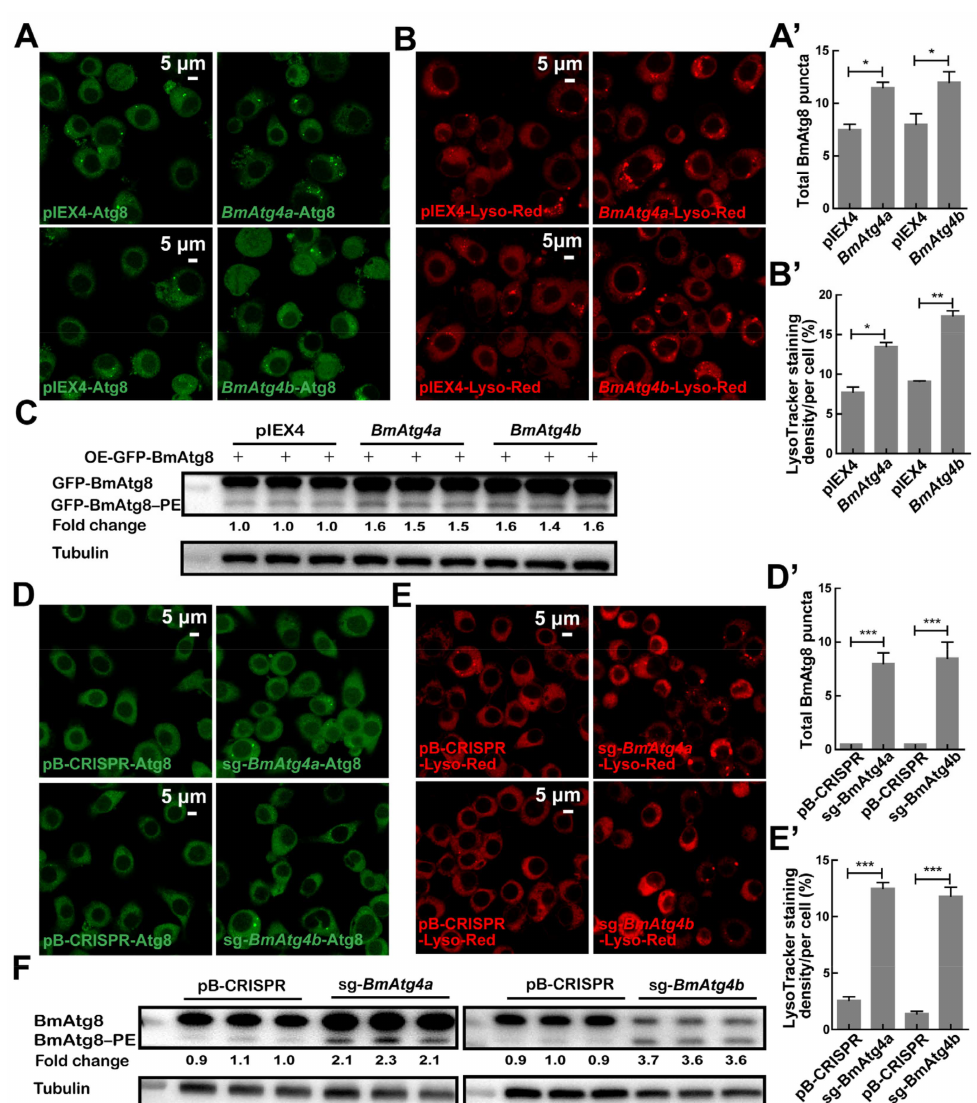
Figure 2. Autophagic function of BmAtg4a and BmAtg4b in BmN cells. ( A ) Punctation of BmAtg8 after overexpression of BmAtg4a and BmAtg4b detected by IF staining. ( A’ ) Quantification of BmAtg8 puncta in ( A ). ( B ) Lysosomal acidification detected by LysoTracker Red staining after overexpres- sion of BmAtg4a or BmAtg4b . ( B’ ) Quantification of LysoTracker Red staining in ( B ). ( C ) After co-overexpression with BmAtg4a or BmAtg4 , the protein levels of GFP-BmAtg8–PE were detected by WB using EGFP primary antibody. Overexpression of the pIEX4 empty vector was used as a control. Fold change means the variation of GFP-BmAtg8–PE protein levels in ( C ). ( D ) Punctations of BmAtg8 after knockout of BmAtg4a and BmAtg4b were detected by IF staining. ( D’ ) Quantification of BmAtg8 puncta in ( D ). ( E ) Lysosomal acidification detected by LysoTracker Red staining after knockout of BmAtg4a or BmAtg4b . ( E’ ) Quantification of LysoTracker Red staining in ( E ). ( F ) WB of endogenous BmAtg8–PE conjugation after knockout of BmAtg4a or BmAtg4b , and tubulin was used as the reference protein. Cells knockout by the empty pB-CRISPR vector was used as a control. Fold change means the variation of BmAtg8–PE protein levels in ( F ). * p < 0.05, ** p < 0.01, *** p <